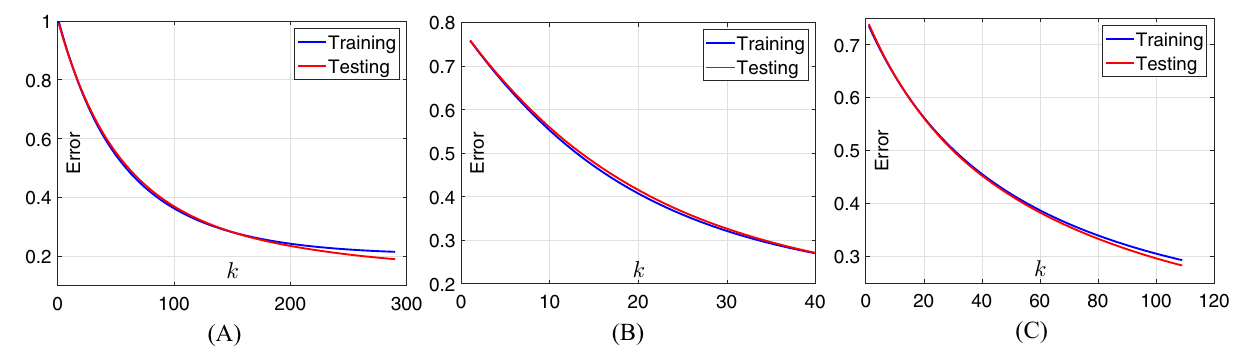
Figure 8. Trends of errors for training and testing dynamic learning network (DLN) in case 2 as the training round k increases. ( A ) DLN trained by NDLA with linear type of mapping function. ( B ) DLN trained by NDLA with tanh type of mapping function. ( C ) DLN trained by NDLA with sinh type of mapping function.